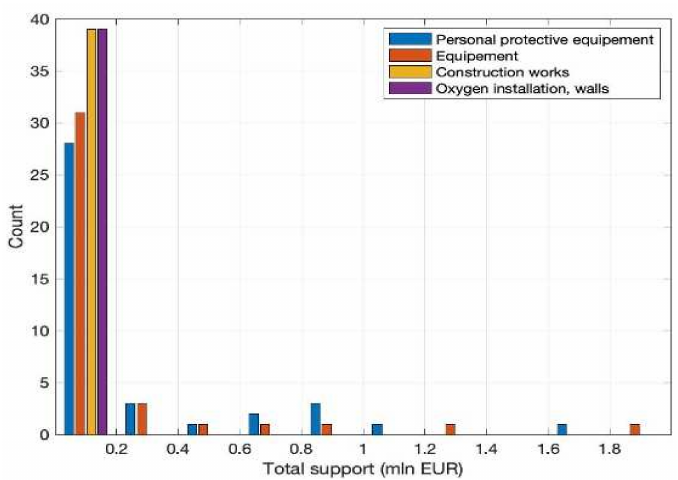
Figure 6. Support structure for COVID pandemic mitigation (values up to EUR 2